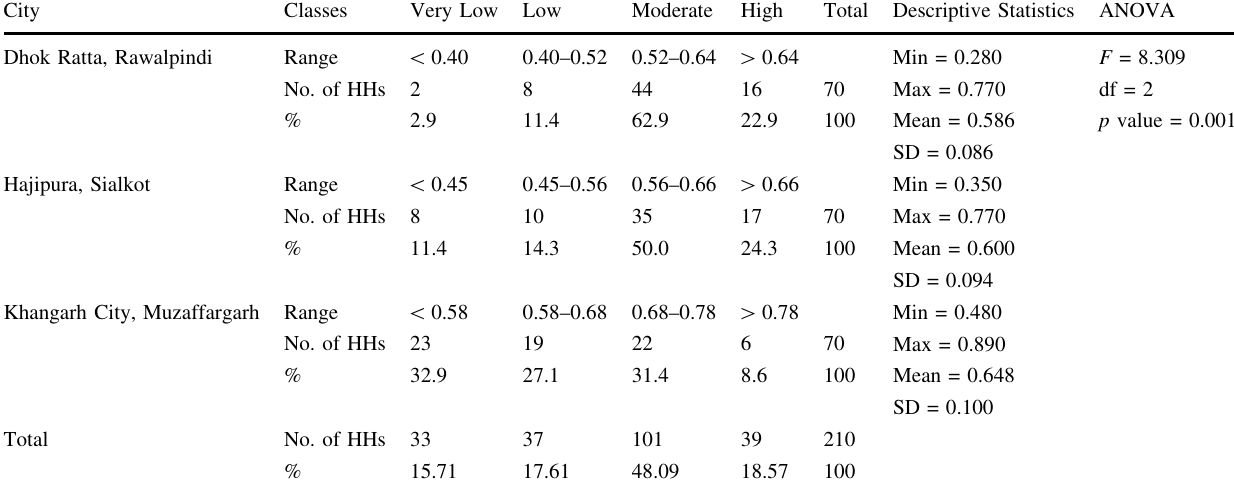
Table 3 Economic vulnerability to urban flooding in Dhok Ratta, Hajipura, and Khangarh City, Punjab Province, Pakistan (HHs = Households; n = 210) City Classes Very Low Low Moderate High Total Descriptive Statistics ANOVA Dhok Ratta, Rawalpindi